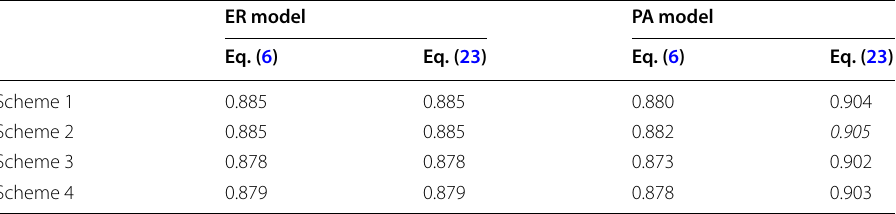
Italic indicates the best score of each experiment